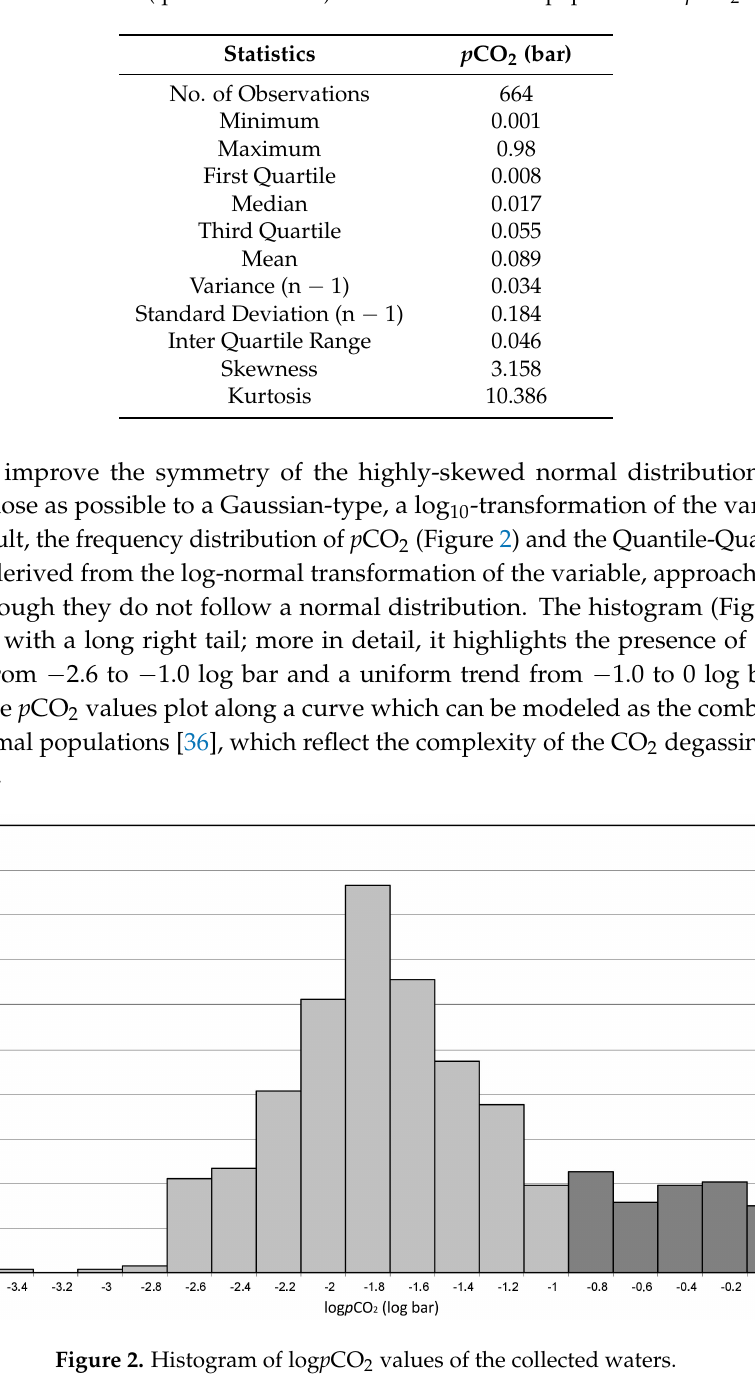
Table 1. Basic statistics (quantitative data) relative to the whole population of p CO 2 values.